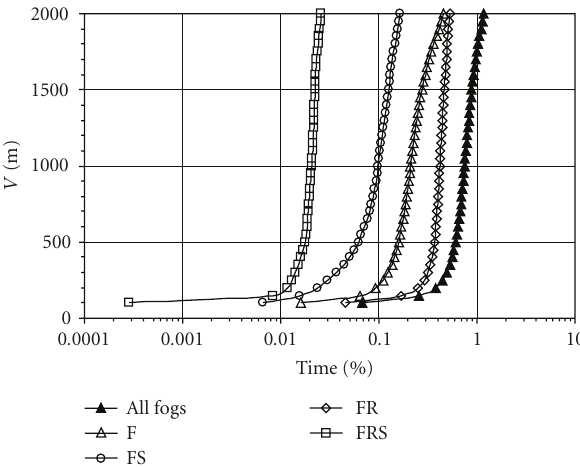
Figure 9: Obtained CDs of attenuation due to all the hydrometeors combined and to the individual hydrometeors separately on the RF path over the 6-year period of observation.